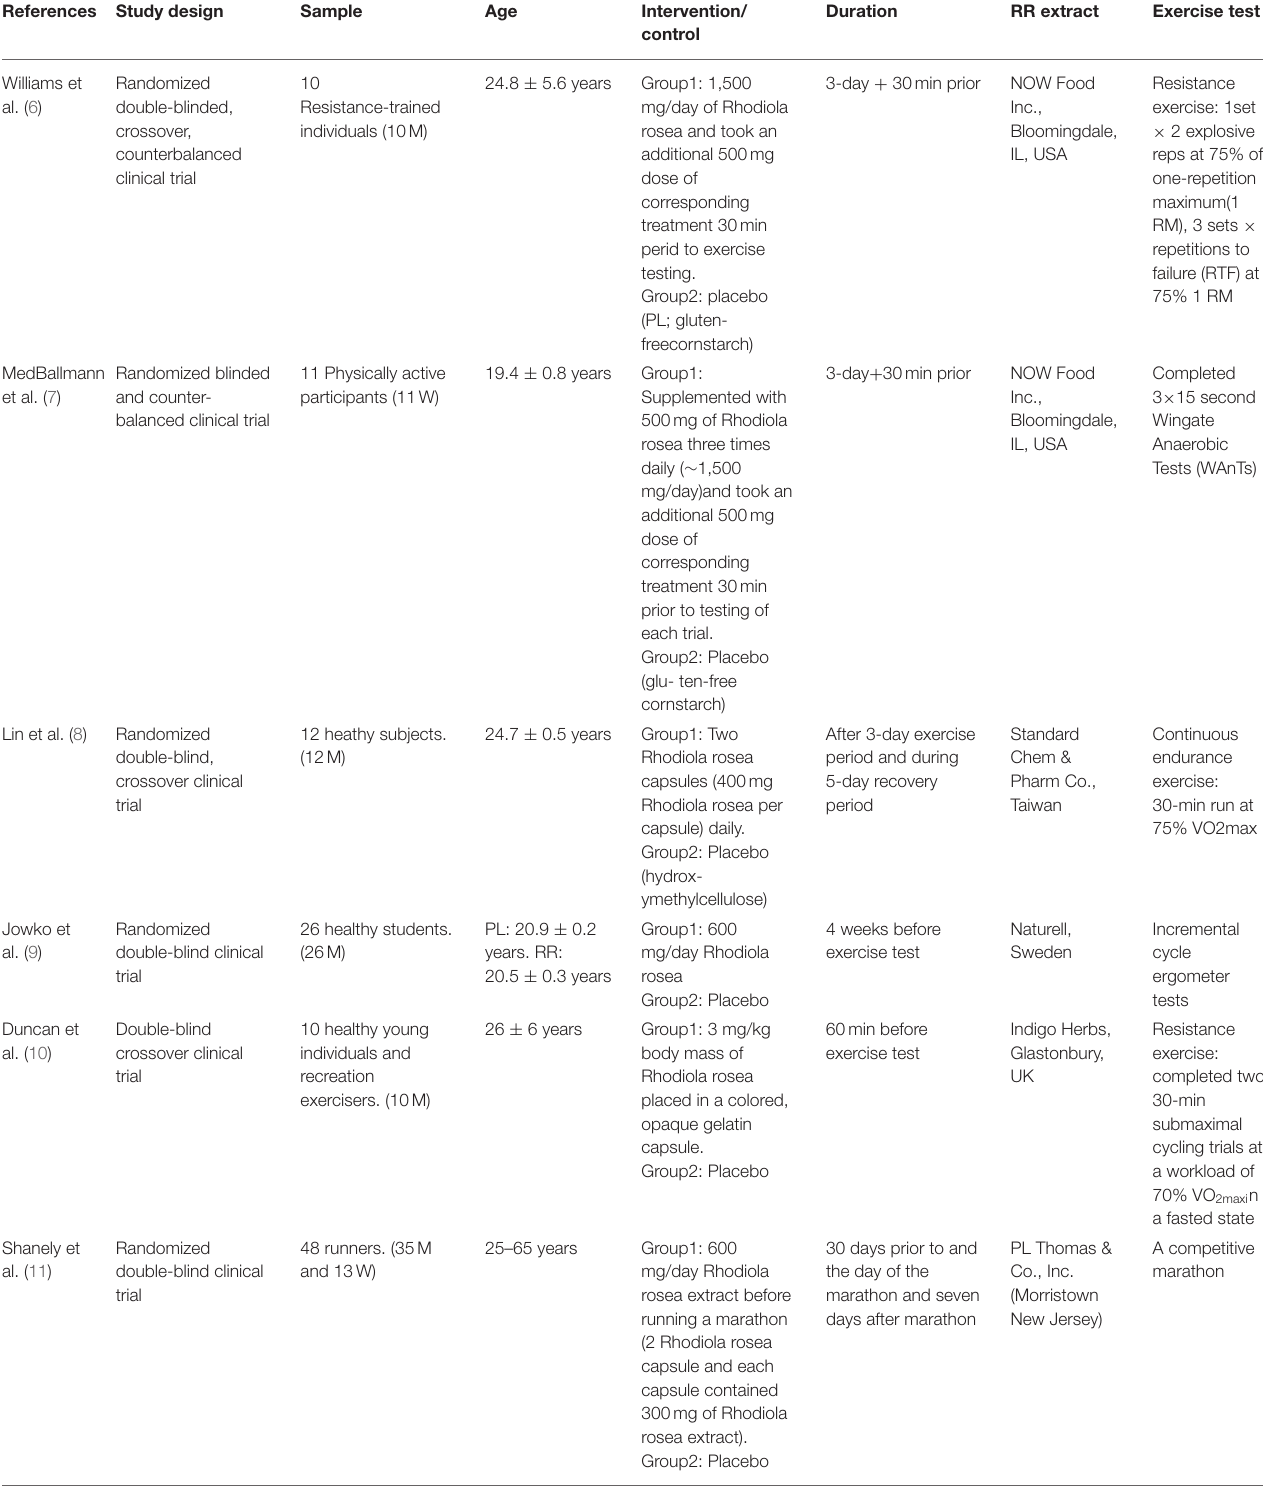
TABLE 1 | Characteristics of the studies